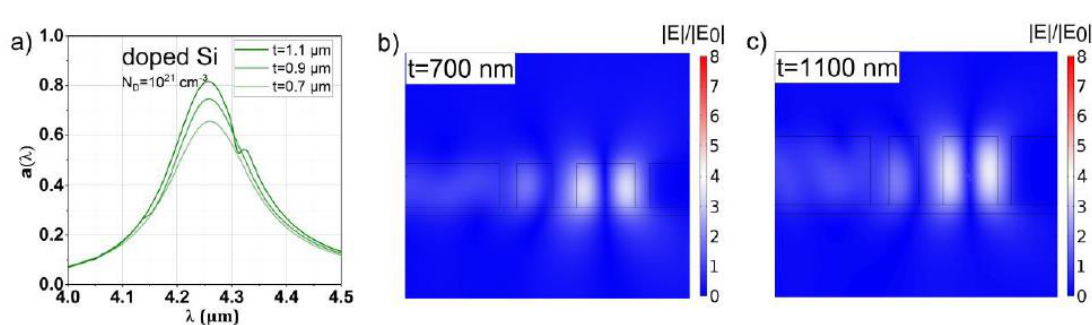
Figure 7. ( a ) Spectral response of the µ -GA optimized Si-based STP structures for slab thicknesses of 0.7, 0.9 and 1.1 µ m, respectively, a resonant wavelength of 4.26 µ m and a doping concentration of 10 21 cm − 3 . The relative field enhancements of the thinnest (0.7 mm) and thickest (1.1 µ m) slab are shown in panels ( b , c ), respectively. The high Q factor of the resonance is reflected by a 3- to 4-fold enhancement of the electric field similar to the resonance featuring Ag.